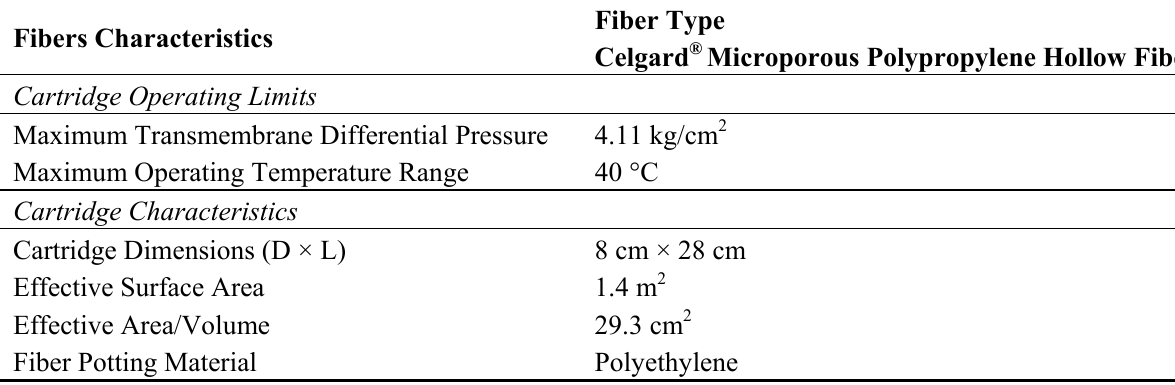
Table 3. Data sheet of the Liqui-Cel ® Extra-Flow 2.5 × 8 ʺ membrane